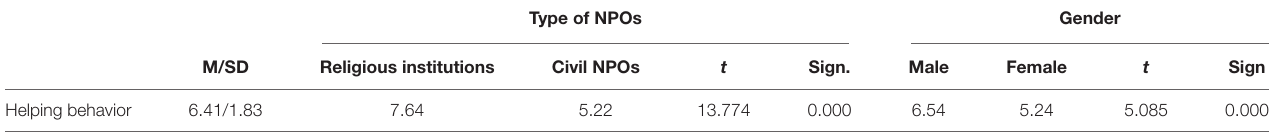
TABLE 6 | t test, means (M), and standard deviation (SD) on volunteer helping